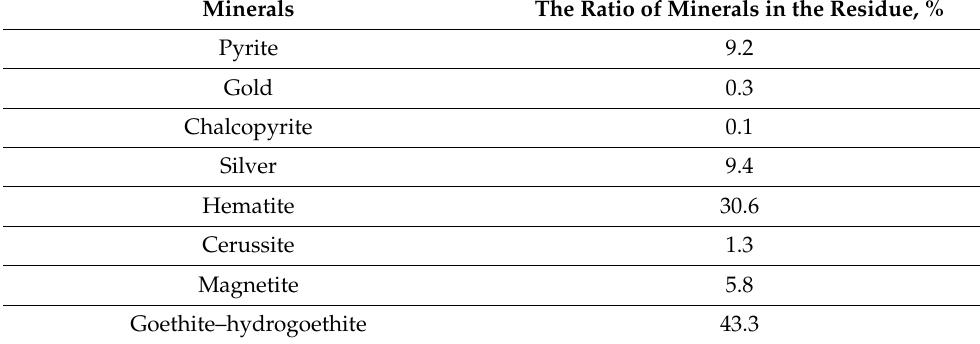
Table 3. Mass fraction of minerals in the